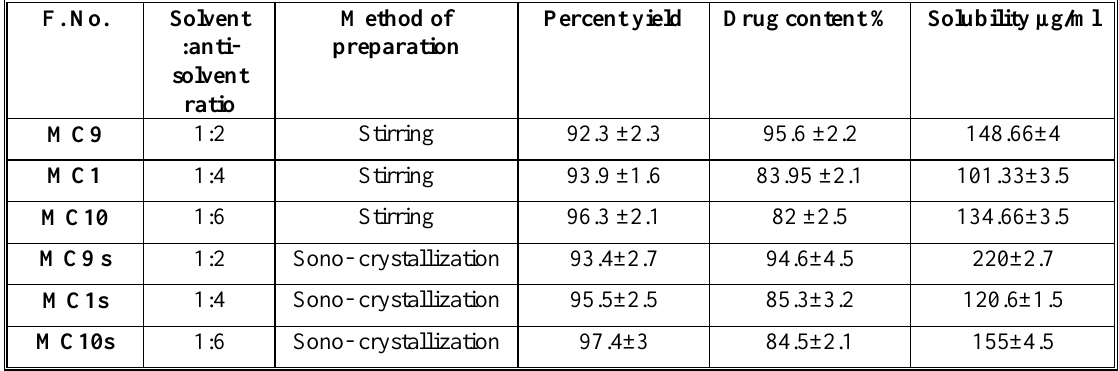
Table (5) SM microcrystals formulas prepared by two method using gelatin polymer F. No.